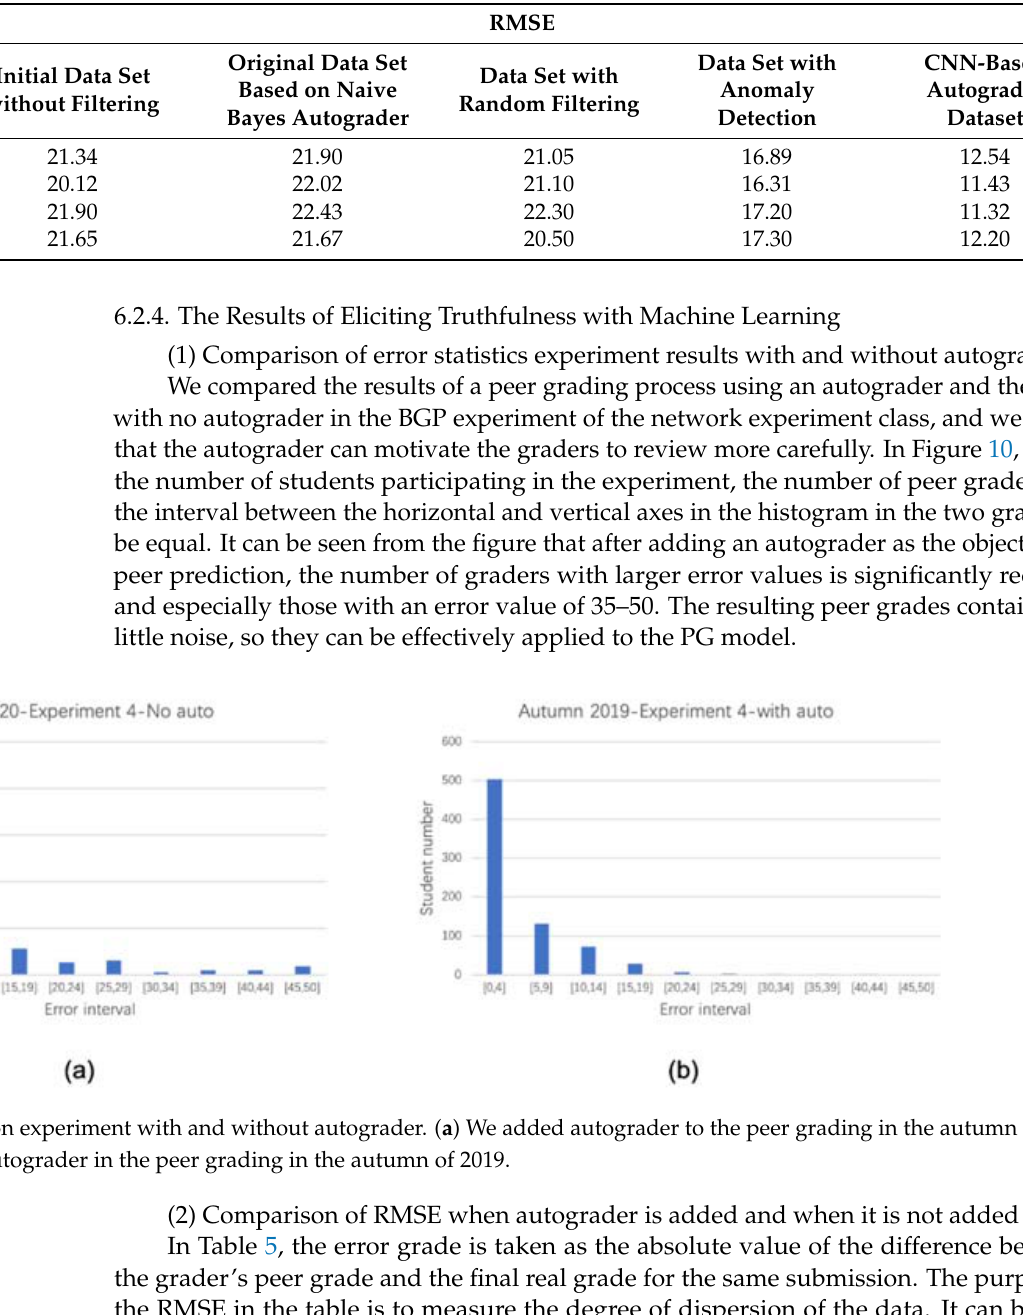
Table 4. Experimental results of the human-machine framework.